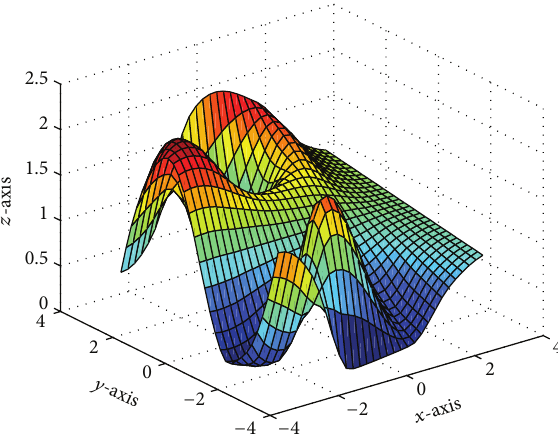
Figure 8: Positivity preserving by using our partially rational bicubic spline.